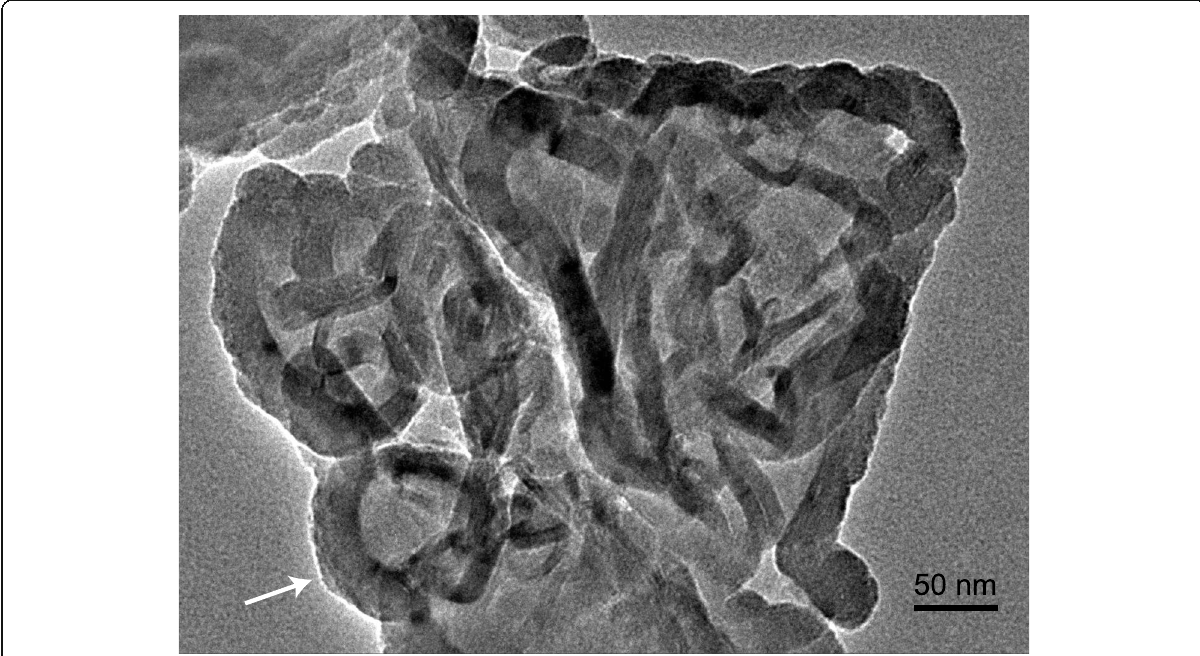
Fig. 4 TEM micrograph of halloysite in the slip surface. The particle indicated by the arrow is a hollow